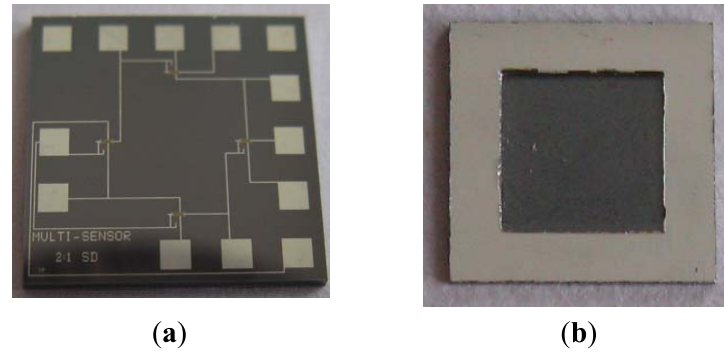
Figure 5. Photograph of the nc-Si/c-Si heterojunction MOSFETs pressure sensor chip with length-width ratio